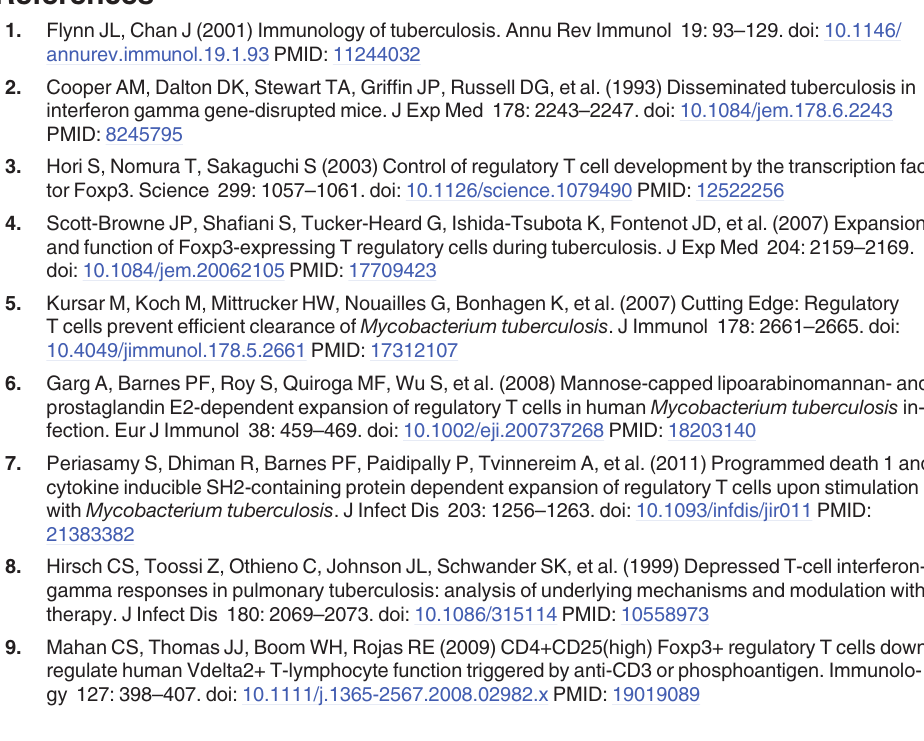
S5 Fig. Macrophages internalize D4GDI. MDM ’ s from six healthy donors were infected with GFP-H37Rv and some infected MDM ’ s were cultured with N-terminal-tagged GST-D4GDI fu- sion protein. After 24 hr, internalization of D4GDI fusion protein was determined by confocal microscopy. S1 Table. The list of up-regulated/down regulated genes in macrophage infected with M. tb . Microarray processing and data analysis were performed using Illumina Single Color HumanHT-12_V4. The fold change in expression level of gene was calculated as a normalized mean of infected macrophage+D4GDI/ infected macrophage ratios of the four biological repli- cates (test sample number) per gene. Genes with > 1.25 fold ratios were considered as up- regulated in the test sample. S2 Table. List of primers used for the